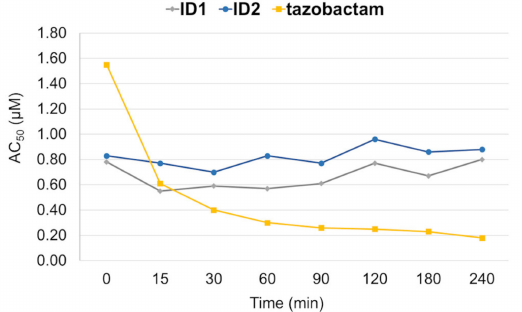
Figure 11. Time dependent inhibition with ID1 , ID2 , and tazobactam .